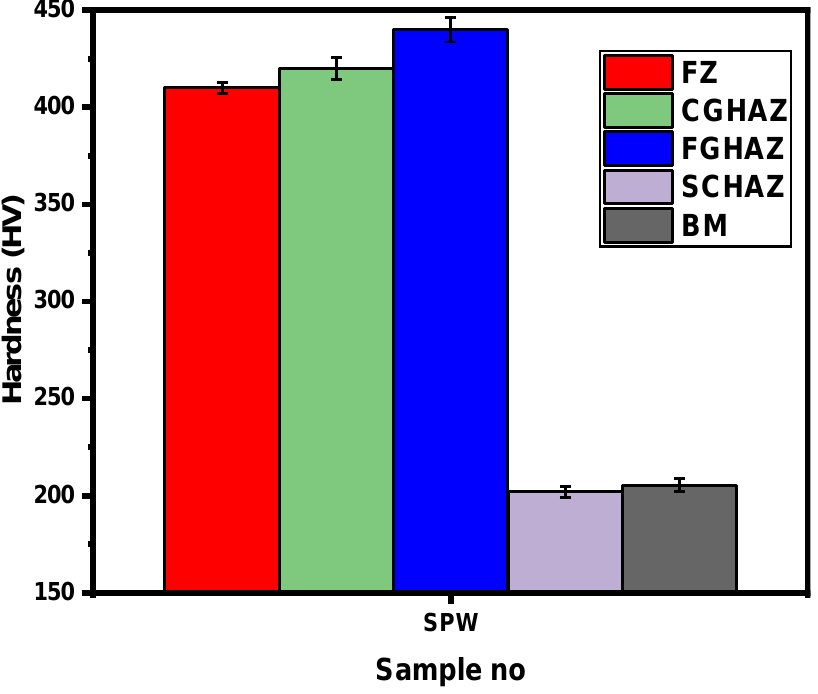
Figure 3. Average microhardness of different weld zones of SPW. Figure 5 shows the load–displacement plot obtained after TS testing. It can been seen that peak load and failure energy were 23.2 kN and 56.7 J, respectively. Figure 5 also illustrates the failure mode of SPW after TS testing, indicating the IF mode (also confirmed by a sudden drop of load in the load–displacement curve). The IF mode in SPW can be attributed to the formation of a brittle martensitic microstructure in the FZ and HAZ. The IF mode of SPW implies that a minimum sizing criterion based on D = 5 guarantee PF. Therefore, it seems that in addition to sheet thickness, the microstructural characteristics of the weldment influence the failure